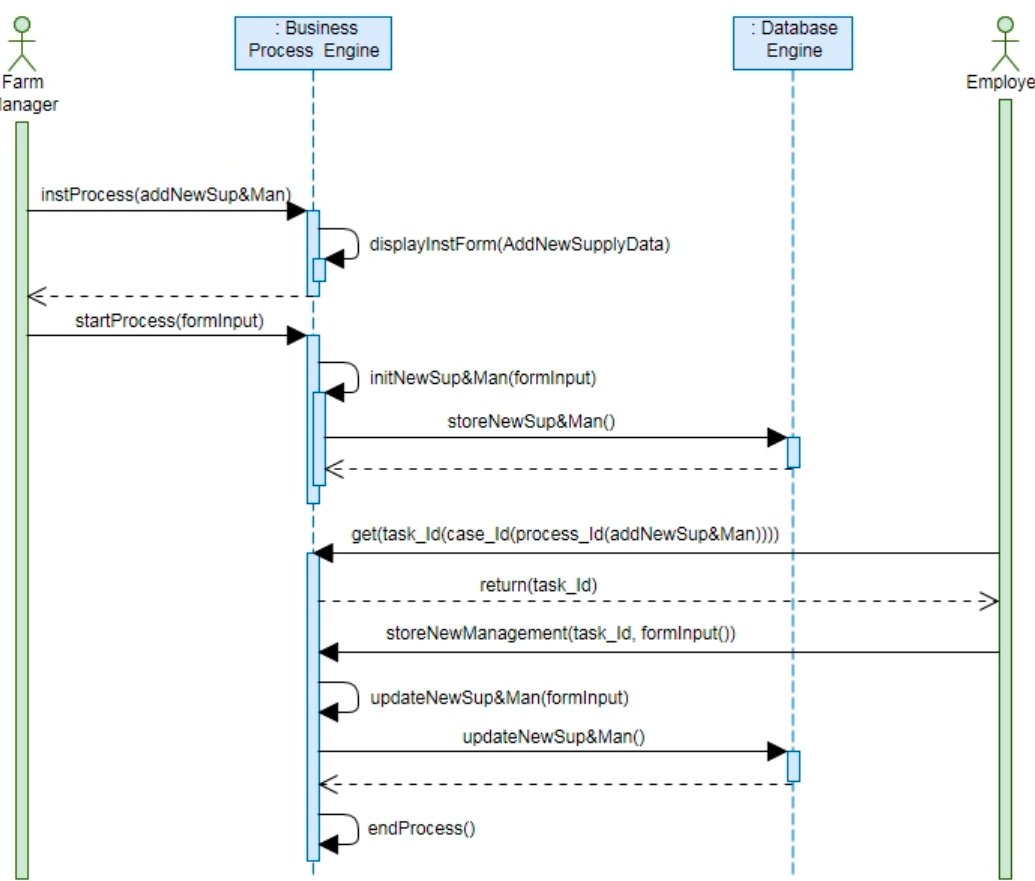
Figure 20. Activity diagram of a business process that involves an asynchronous collaboration of two users of different groups. In detail, the diagram shows the collaboration between different software components, and users during the execution of the process “Warehouse Management”.